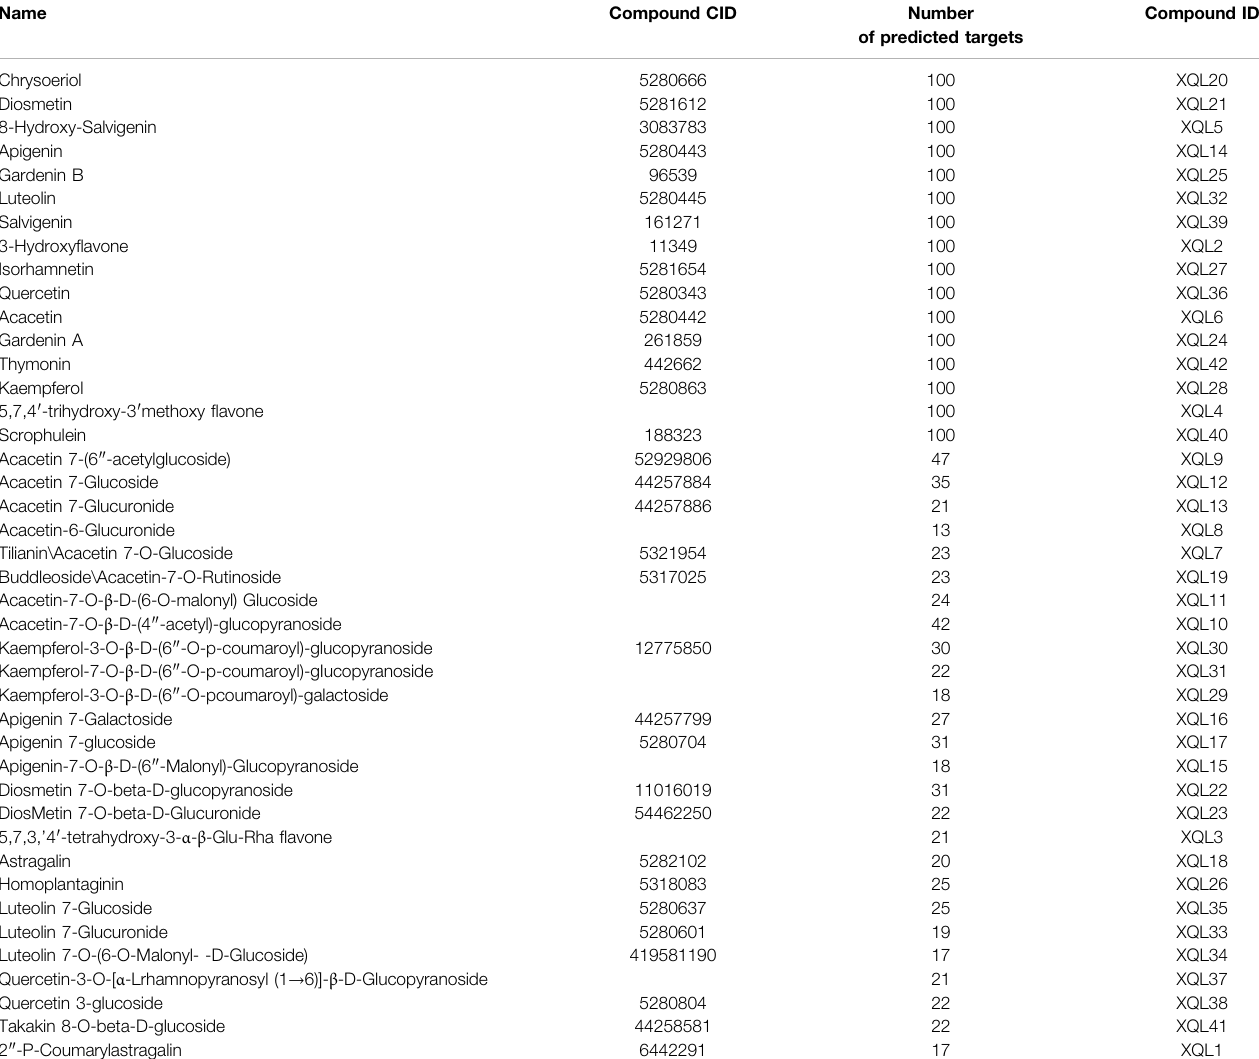
TABLE 4 | Information including name, compound CID, number of predicted targets, and compound ID used in the present study on the 42 fl avonoids in Dracocephalum moldavica L.